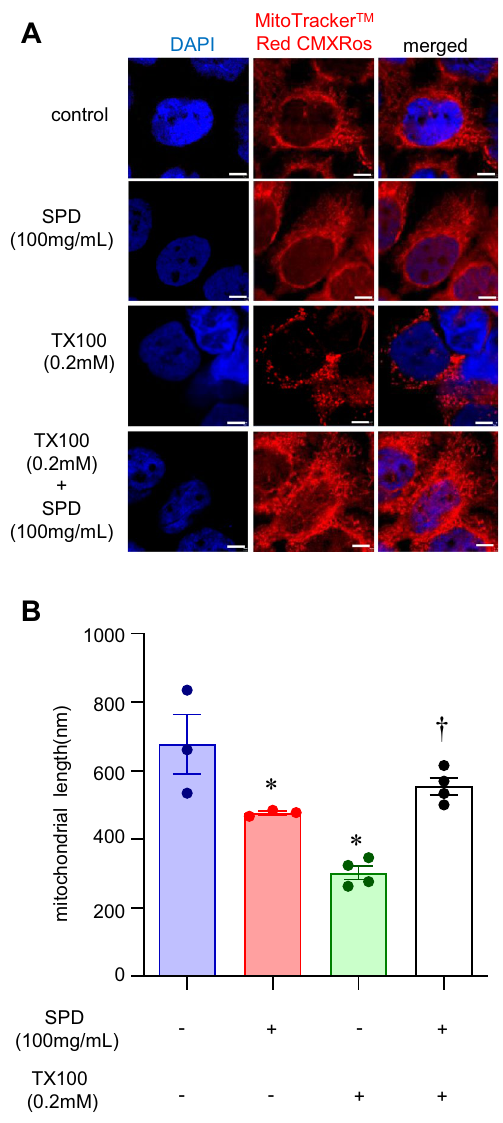
Figure 6. SPD rescued TX100-induced mitochondrial fragmentation. Human keratinocytes (HaCaT) were exposed to TX100 (0.2 mM) for 1 h in presence of SPD (100 mg/ml). Cells were then stained with MitoTrackerRedCMXRos. ( A , B ) Representative microscopic images and quantification of tubular length of the mitochondria was assessed by confocal microscopy for at least 100 mitochondria selected from the three different regions of interests per sample. Scale, 10 µm. Data represent mean ± SEM (n = 3–4). * p < 0.05 compared to control (TX100-untreated). † p < 0.05 compared to TX100-treated